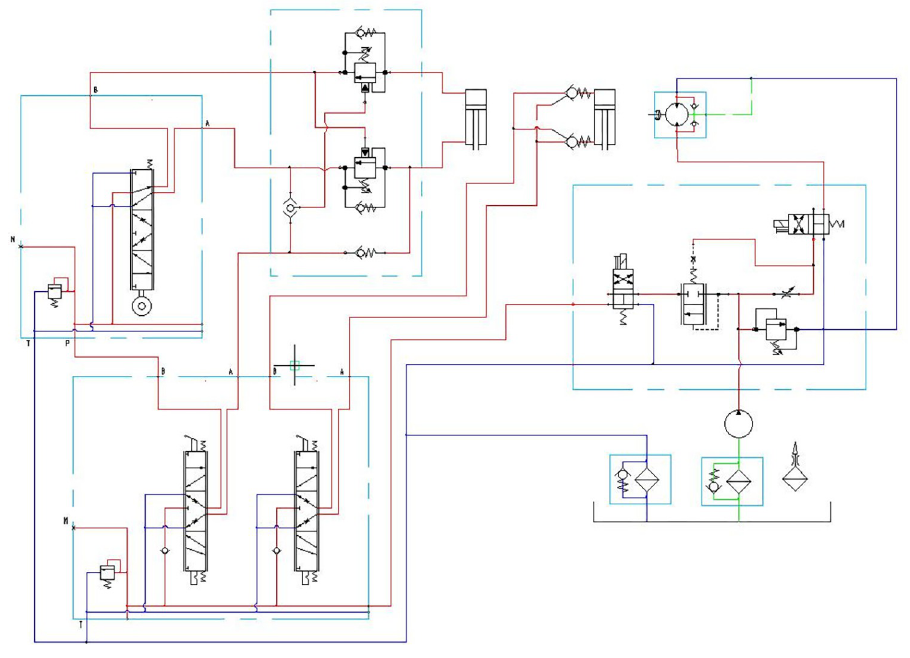
Fig 5. Hydraulic system